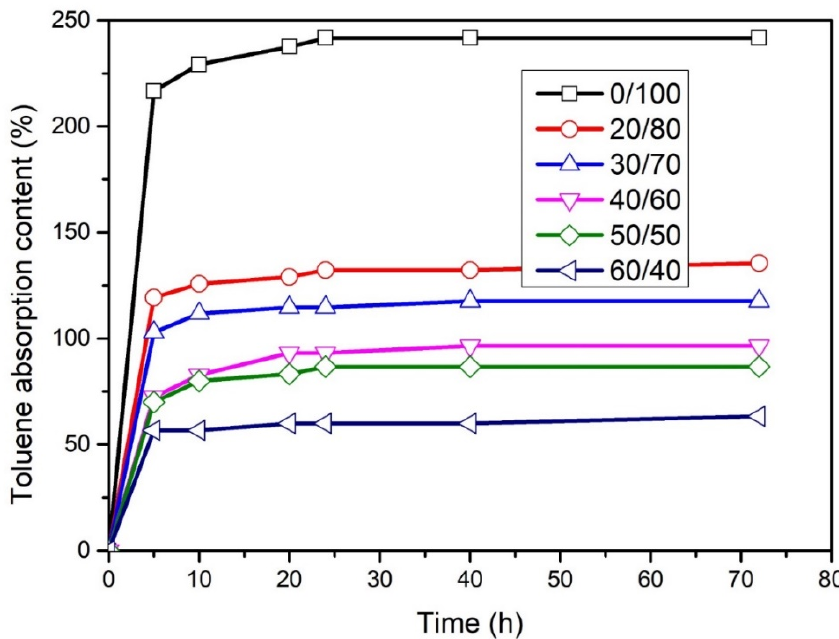
Figure 7. Toluene absorption curve of WLF/NBR composite.